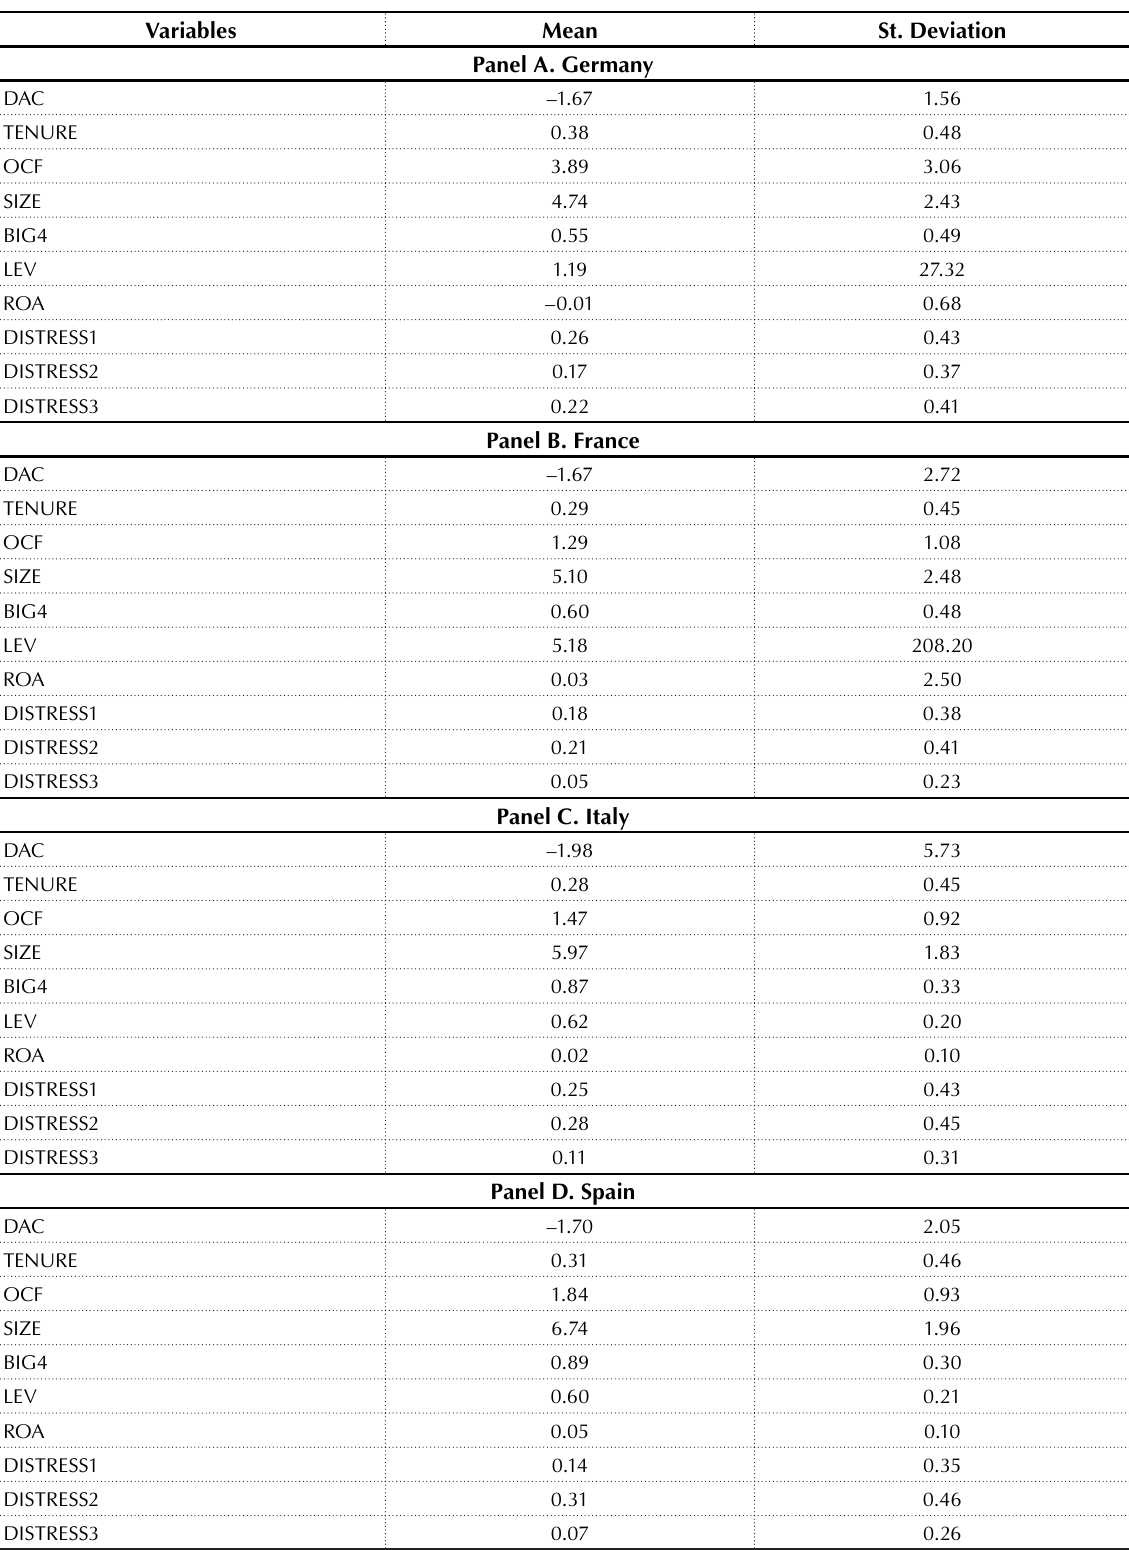
Table 1. Descriptive statistics for Germany, France, Italy and Spain outside the financial crisis for change of GDP >